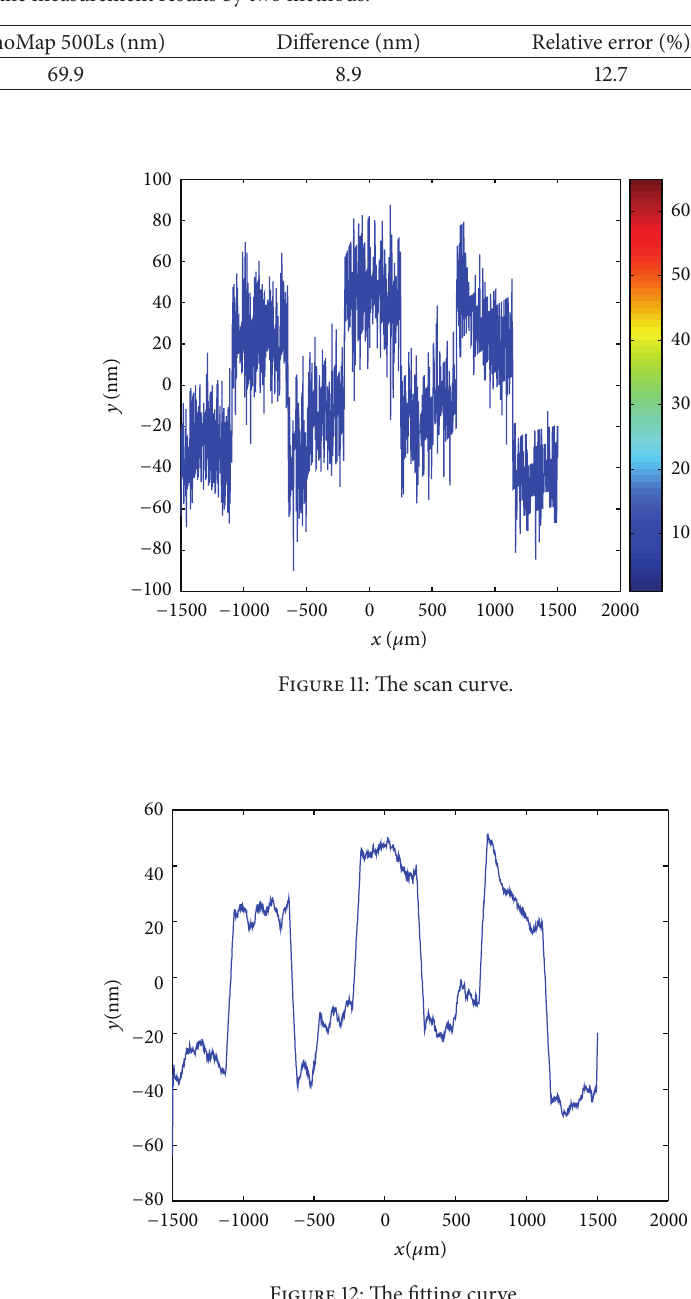
Figure 12: The fitting